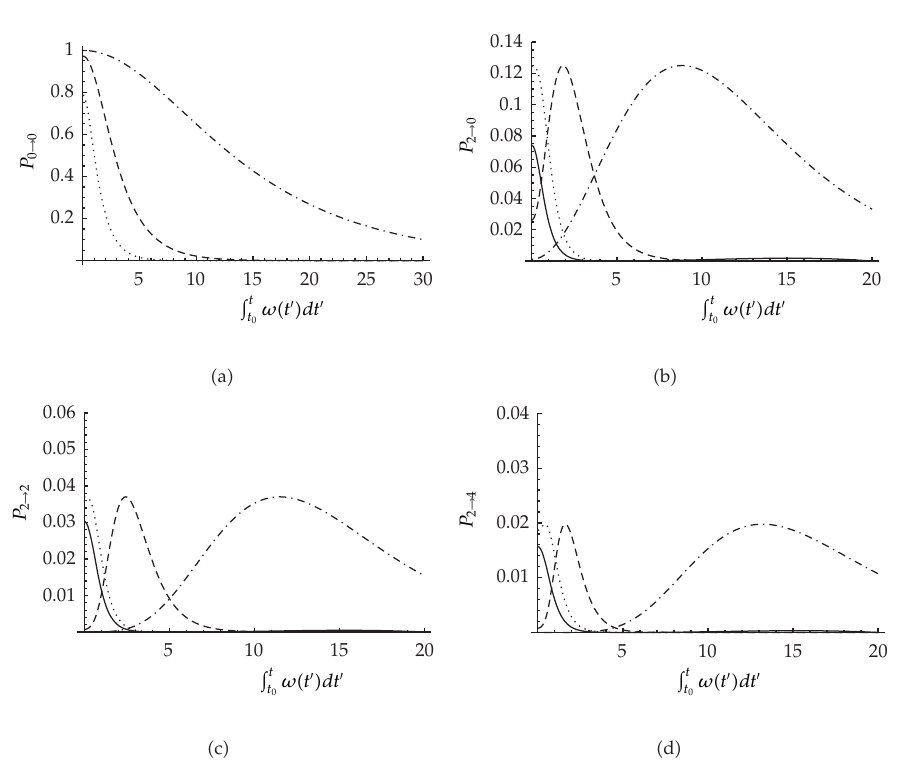
Figure 2: (cid:4) a (cid:5) P 0 → 0 when δ 0 (cid:8) 0 . 1 , 0 . 5 , 2; (cid:4) b (cid:5) P 2 → 0 when δ 0 (cid:8) 0 . 1 , 0 . 5 , 3 , 10; (cid:4) c (cid:5) P 2 → 2 when δ 0 (cid:8) 0 . 1 , 0 . 5 , 5 , 10;